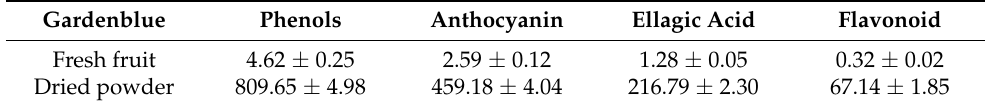
Table 2. Main polyphenols (mg/g) of Gardenblue blueberries.